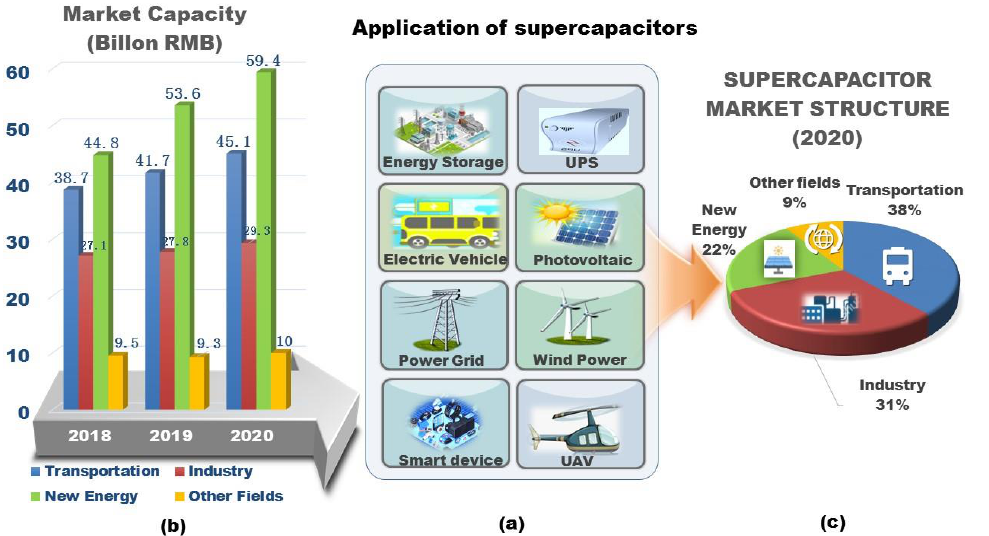
Figure 5. ( a ) Application field of supercapacitor. ( b ) Market segment capacity of supercapacitor